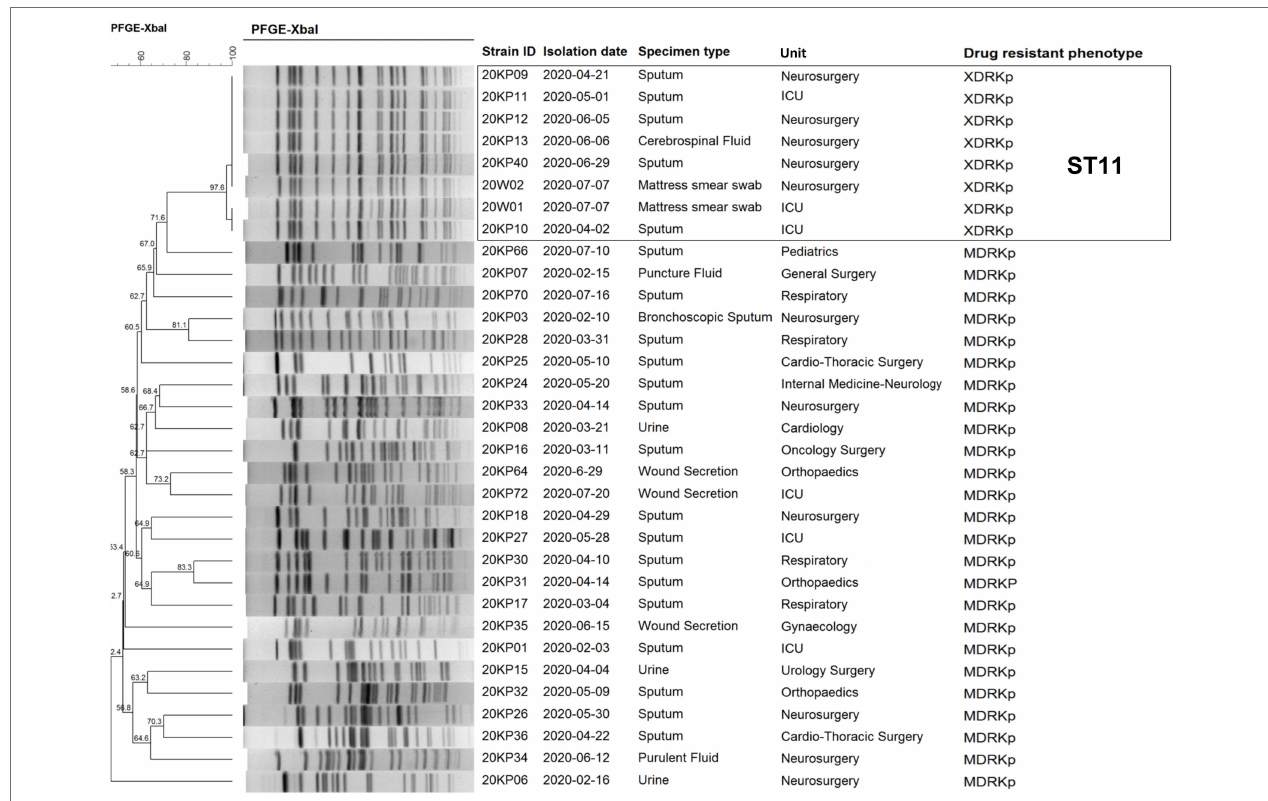
FIGURE 2 | Clustering map of 33 Klebsiella pneumoniae strains by pulsed-field gel electrophoresis.